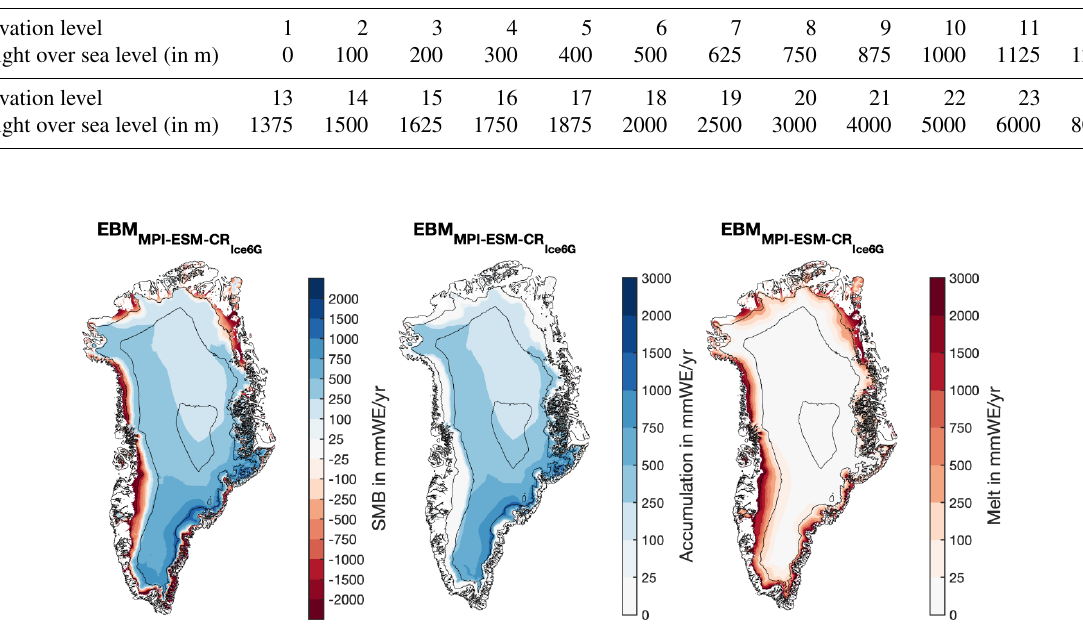
Table A1. Elevation classes used in the EBM.